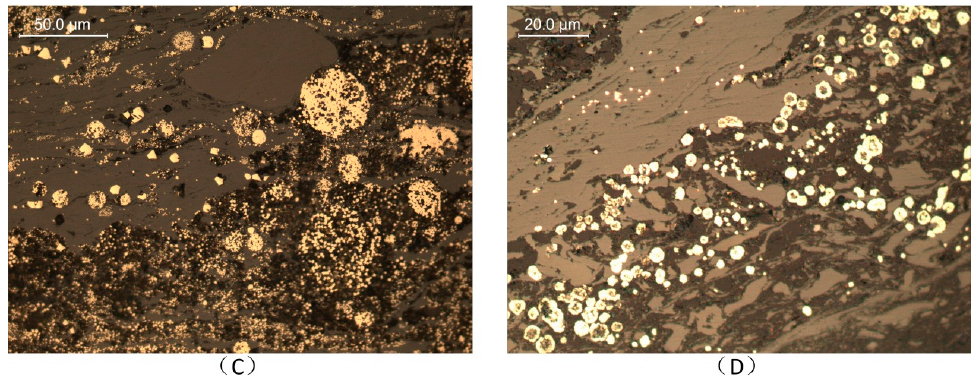
Figure 5. Pyrite in the C25 coal. ( A ) Particles of pyrite in sample C25-2; ( B ) cell-filling pyrite in sample C25-3; ( C ) framboidal pyrite in sample C25-3; ( D ) needle-like forms combined with marcasite in sample C25-3. Optical microscope, reflected light.